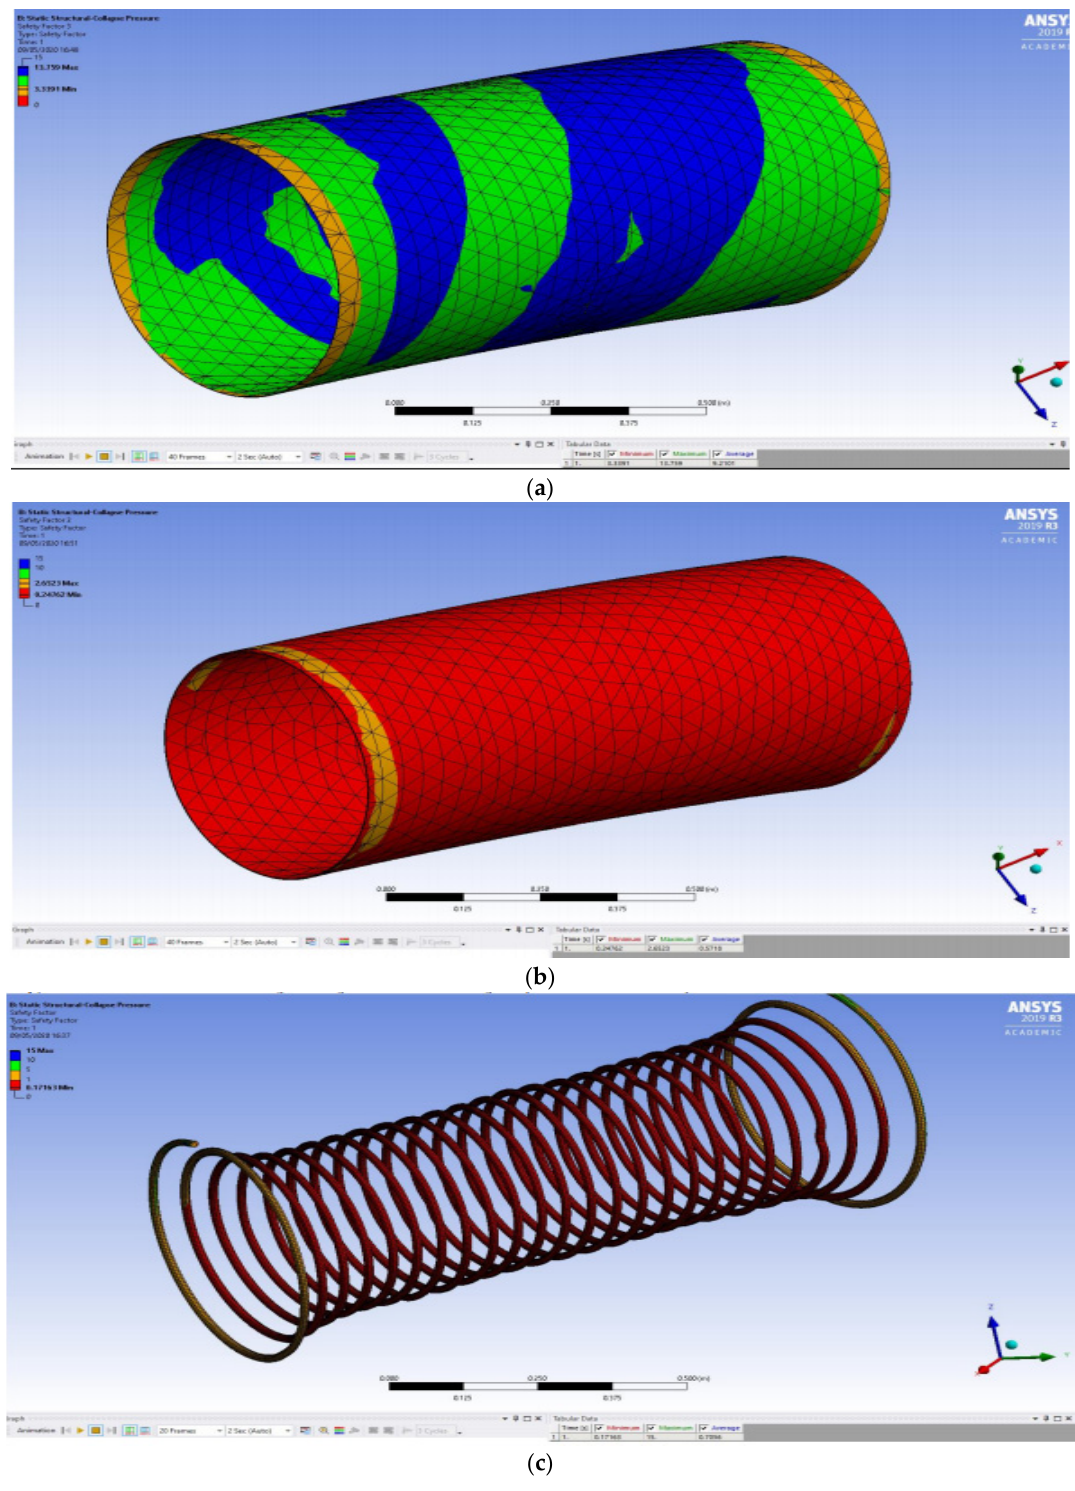
Figure 14. Factor of Safety analysis of ( a ) holding ply (glass fibre-reinforced nylon 6/6), ( b ) inner liner (structural steel), and ( c ) helix layer (structural steel) using load case without end fitting.